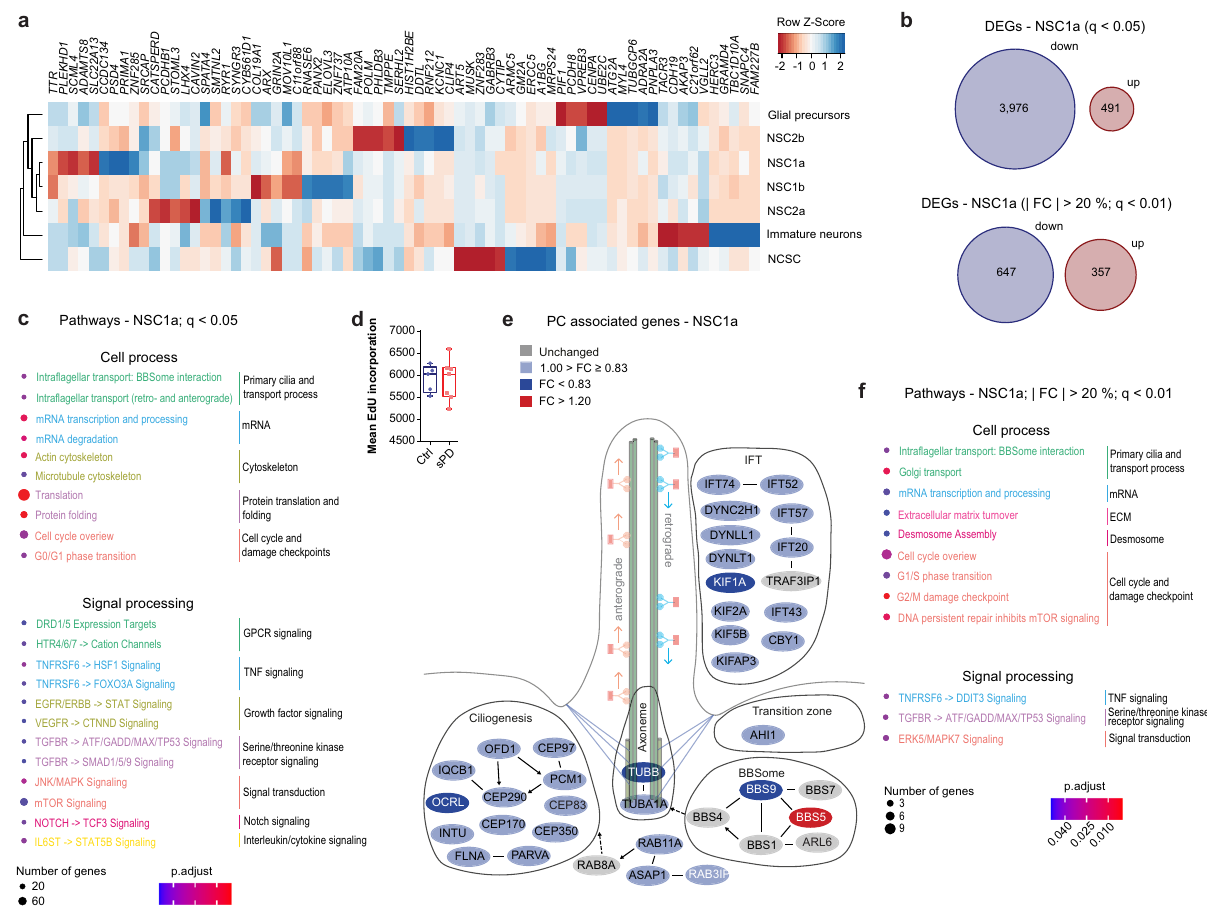
Fig. 4 | Cluster speci fi c gene expression changes in sPD pathology. a Heatmap showinglog2transformedfoldchanges(FC)withcolumnsscaledbyz-scoreforthe top tenup-and downregulated DEGsofeach cellcluster.Hierarchicalclustering of cell types represented by the dendrogram reveals their similarity across DEGs. b Number of all and most (| FC|>20%, q <0.01) up- and downregulated DEGs in NSC1a. c Enriched pathways of the categories Cell process and Signal processing analyzed using Pathway Studio for the DEGs of NSC1a ( q <0.05). P -values were determined by one-sided Fisher ’ s exact tests. FDR corrected p -values are repre- sented by q -values. d Cell proliferation rate of hNPCs determined by EdU incor- poration after 2h of EdU treatment. n =5 Ctrl and 7 sPD clones, in triplicates. P -values were determined by two-sided t -test. e Visualization of the “ Intra fl agellar